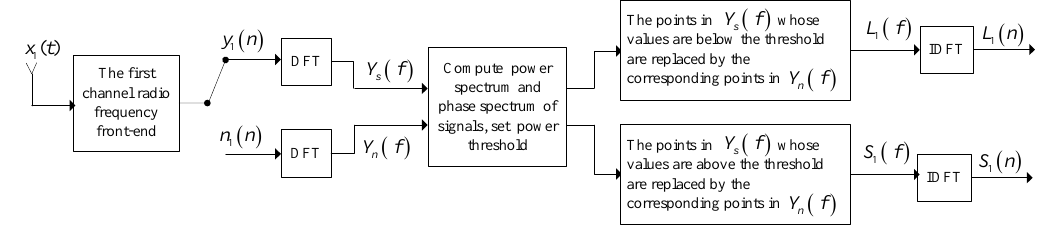
Figure 5. Proposed blind signal separation method structure.